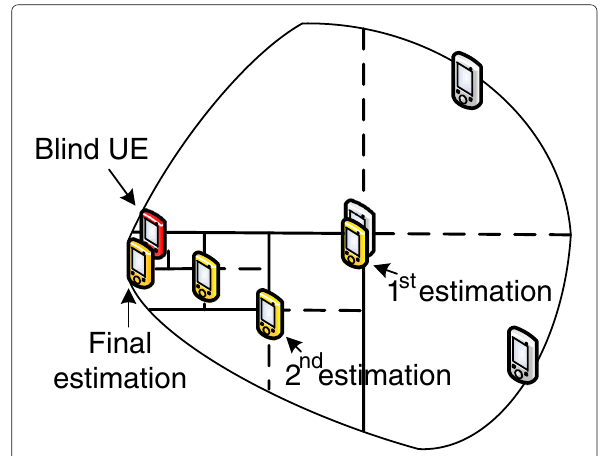
Algorithm 2 needs as input parameters the set of the three